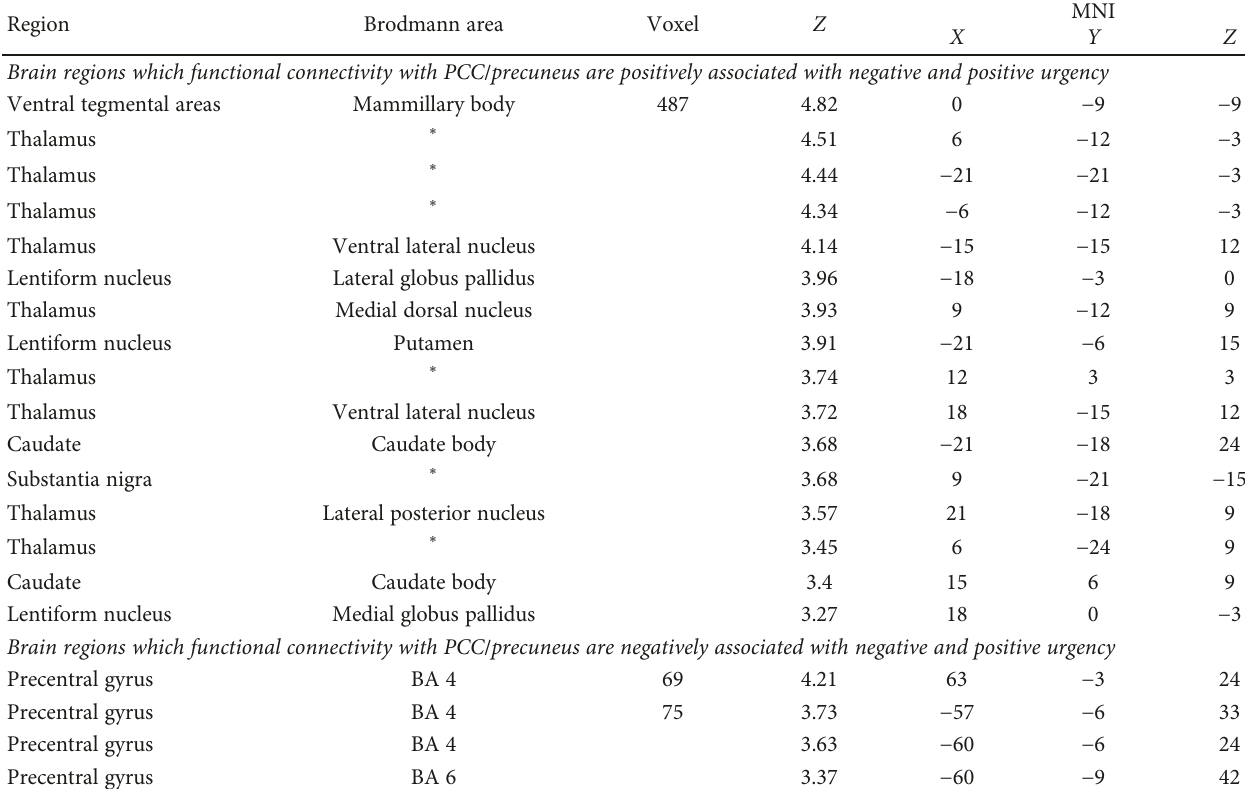
Table 2: The foci of brain areas in which functional connectivity with PCC/precuneus was signi fi cantly correlated with negative or positive urgency ( P FWE = 0 05 , family-wise error correction). Region Brain regions which functional connectivity with PCC/precuneus are positively associated with negative and positive urgency